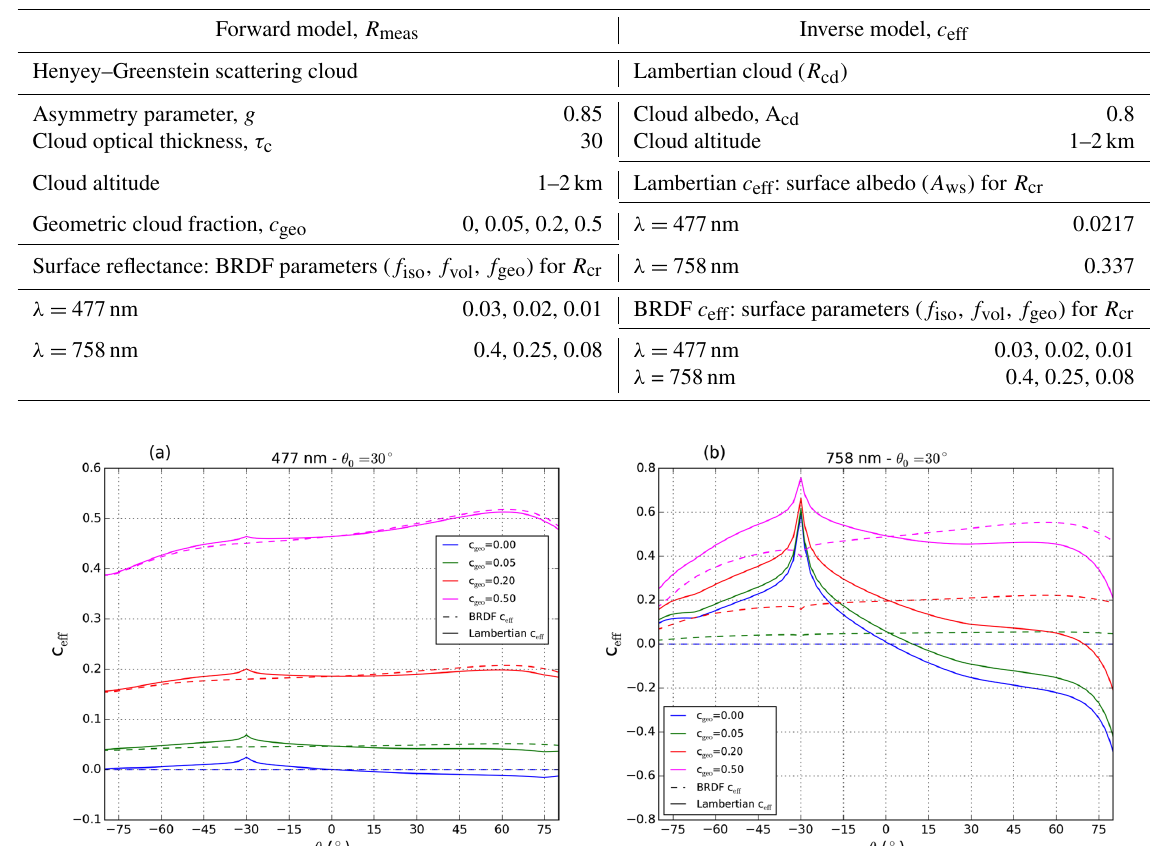
Figure 7. Simulated effective cloud fraction at (a) 477nm and (b) 758nm as a function of viewing zenith angle for different geometric cloud fractions along the principal plane ( ϕ − ϕ 0 = 180 ◦ for negative θ and ϕ − ϕ 0 = 0 ◦ for positive θ ). θ 0 = 30 ◦ and c geo = 0, 0.05, 0.2, and 0.5. At 477nm: BRDF parameters (solid line) ( f iso , f vol , f geo ) = ( 0 . 03 , 0 . 02 , 0 . 01 ) and for Lambertian surface A ws = 0 . 0217 (dashed line). At 758nm: BRDF parameters (solid line) ( f iso , f vol , f geo ) = ( 0 . 4 , 0 . 25 , 0 . 08 ) and for Lambertian surface A ws = 0 . 337 (dashed